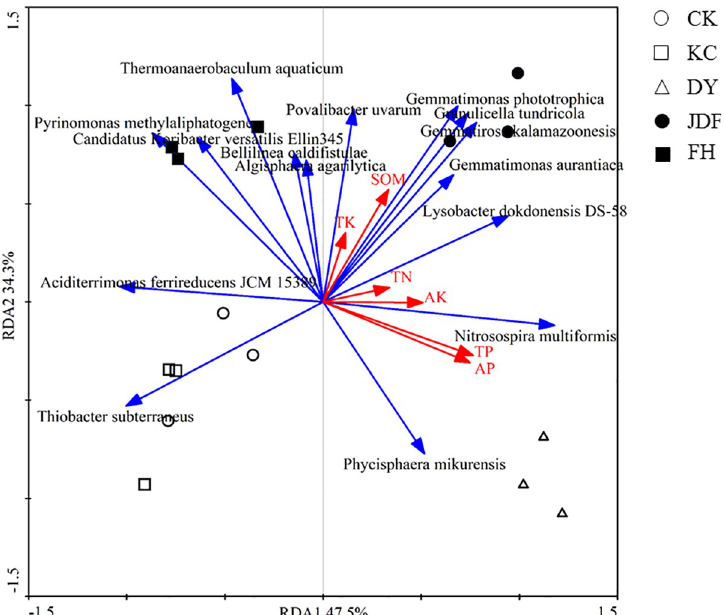
Fig 5. RDA analysis of the correlations between the physiochemical characteristics of the soil and the microbial species in the maize rhizosphere. The blue arrows represent the strains, and the red arrows represent the properties of the soil. The length of the arrows indicates the degree of correlation between the strain and the sample distribution. The angle between the two arrow lines indicates the correlation. The smaller the angle was, the stronger the correlation. CK, KC, DY, JDF, and FH groups indicate control, B . subtilis , B . licheniformis , B . amyloliquefacien s, and combined strains treatments,